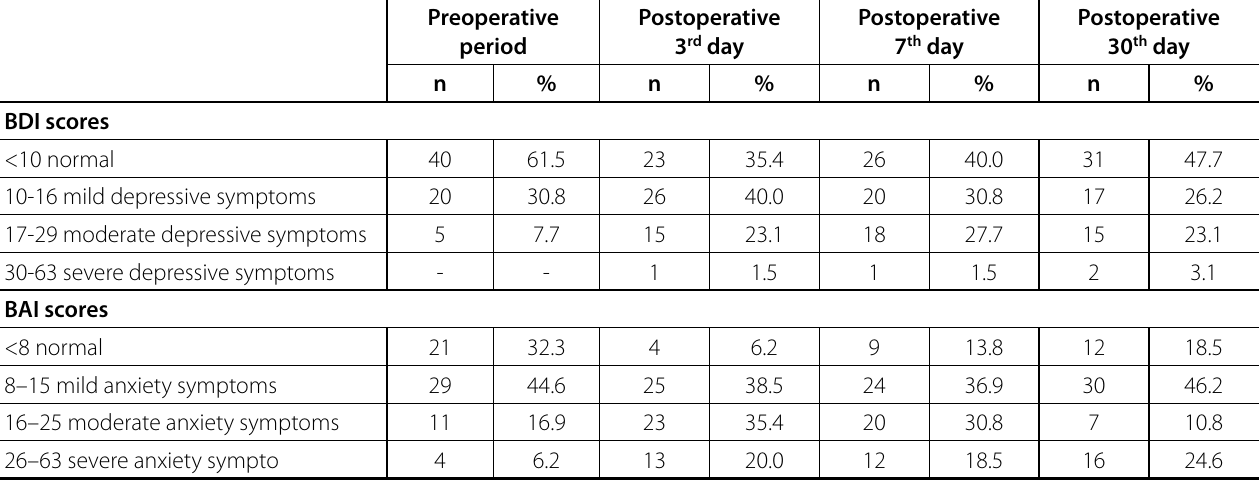
Table 4 . Percentage of patients with symptoms of anxiety and depression in the preoperative and postoperative periods.